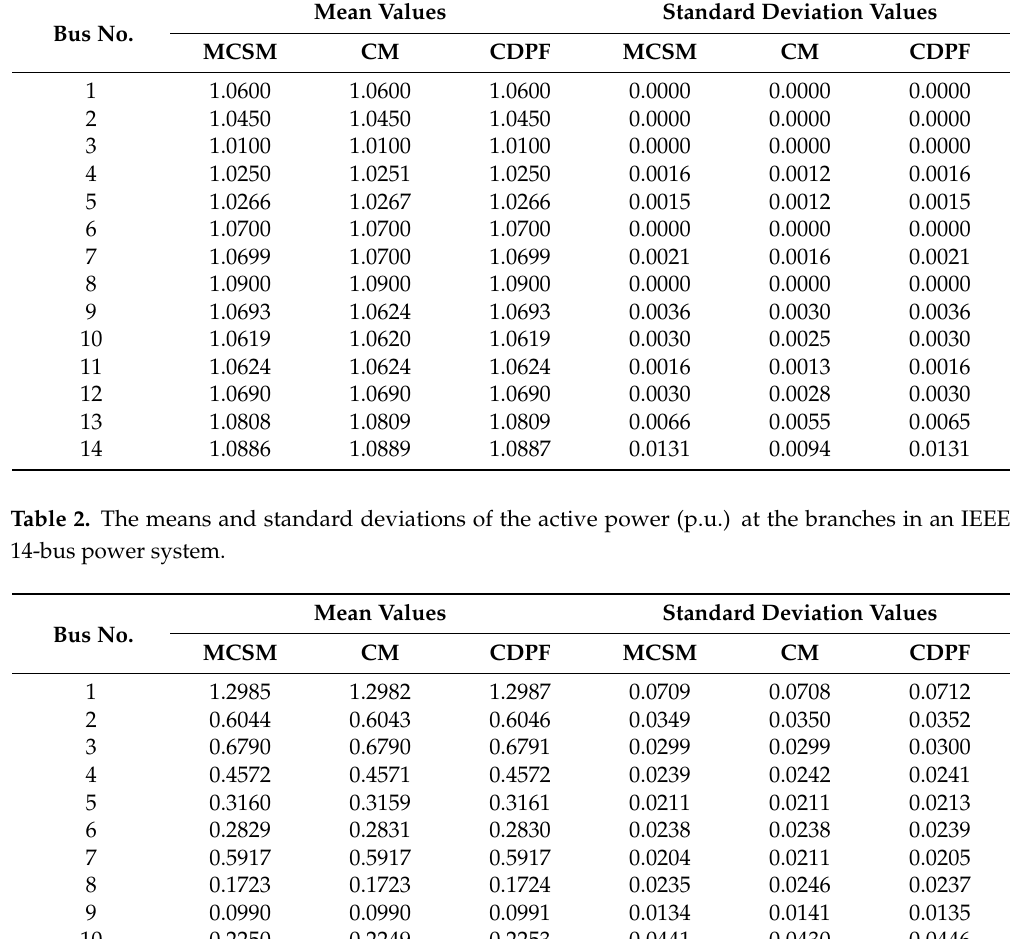
Table 1. The means and standard deviations of the voltage magnitude (p.u.) in an IEEE 14-bus power system.